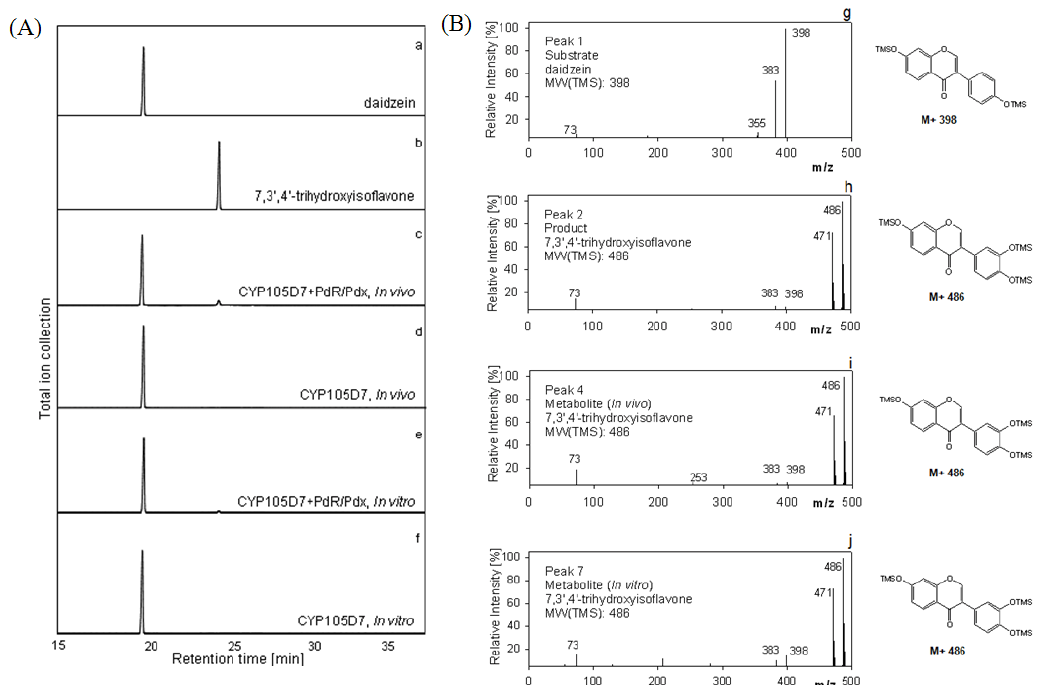
Figure 5. Gas Chromatography-Mass Spectroscopy analyses for daidzein hydroxylation in vivo and in vitro reaction. ( A ) GC chromatograms of the hydroxylated metabolite of daidzein. a, authentic daidzein; b, authentic 7,3',4'-trihydroxyisoflavone c, in vivo reaction with heterologously expressed P450 and redox partner; d, in vivo reaction with P450; e, in vitro reaction with P450 and PdR/Pdx; f, in vitro reaction with P450; ( B ) Representative electron impact mass spectra of TMS derivatives of daidzein and metabolite. g, mass spectrum of authentic daidzein (Peak, 1); h, mass spectrum of authentic 7,3',4'-trihydroxyisoflavone, (Peak, 2); i, mass spectrum of reactant, 7,3',4'- trihydroxyisoflavone (Peak, 4); j, mass spectrum of reactant, 7,3',4'-trihydroxyisoflavone (Peak, 7). Peak 3, 5, 6 and 8 represent mass spectra of daidzein. Retention times: daidzein, 19.5 min and 7,3',4'-trihydroxyisoflavone, 24.1